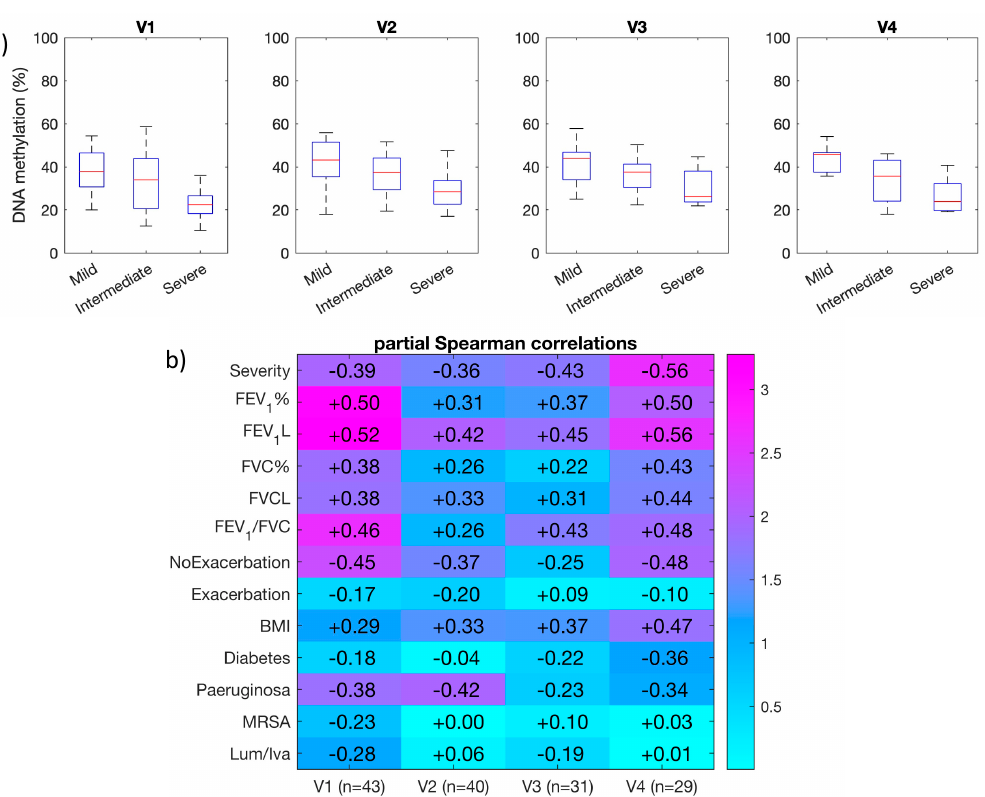
Figure 3. DNA methylation of ATP11A (cg11702988) in sputum samples from the MethylBiomark cohort at four time points (V1, V2, V3 and V4). ( a ) DNA methylation of mild, intermediate, and severe CF patients. ( b ) Age- and sex-adjusted Spearman correlations between DNA methylation and continuous or binary phenotypic traits. Severity refers to the groups of mild, intermediate or severe CF patients. NoExacerbation, number of exacerbations in 24 months after V1. Exacerbation, presence of exacerbation at the visit. MRSA, methicillin-resistant Staphylococcus aureus . Lum/iva, lumacaftor/ivacaftor treatment. The color ladder represents minus the decimal logarithm of the p -value associated with the partial Spearman correlations.